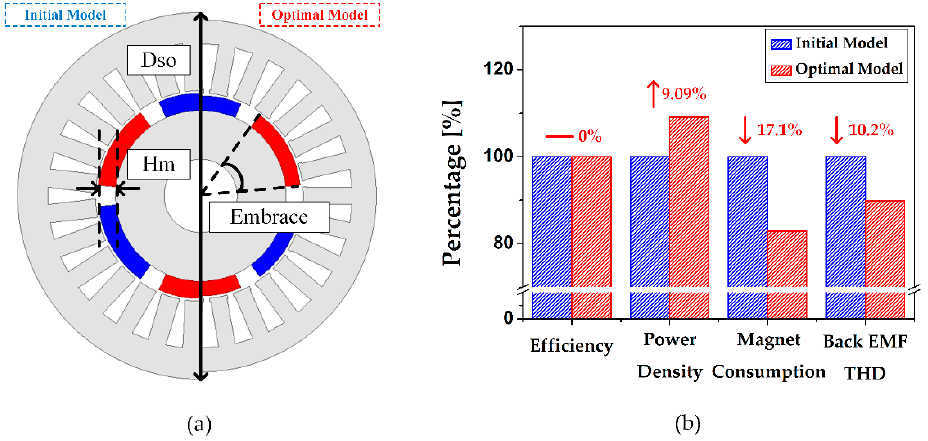
Figure 8. Initial and optimal model comparison ( a ) Size; ( b ) Parameters.